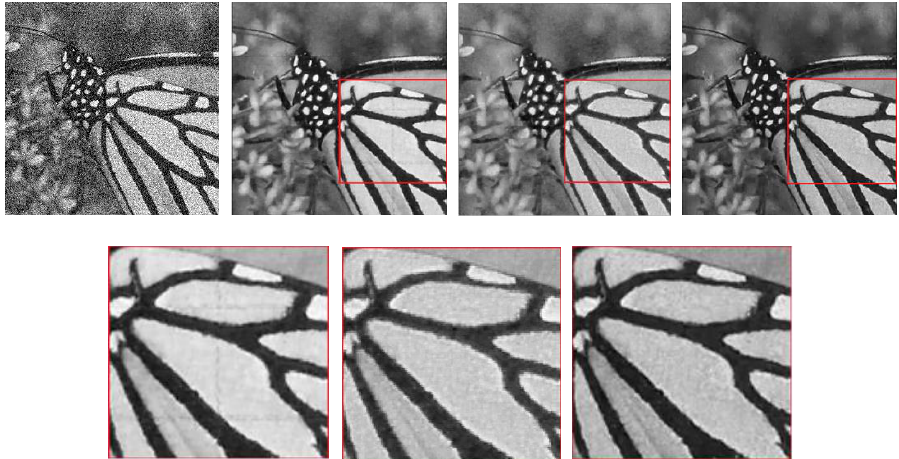
Figure 8. Enlarged denoised images. The images from left to right in the first row are input noisy image, restored image of ResNet, restored image of ResNet with “ dilation convolution ” + “ symmetric padding, ” and restored image of FbResNet; the images in second row, from left to right, are the enlarged images of the red box corresponding to the position in the first row.